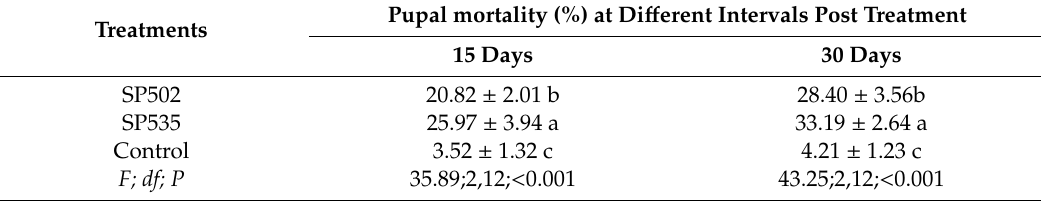
Table 2. Percentage mortality of B. tabaci pupa in response to colonization of Cordyceps